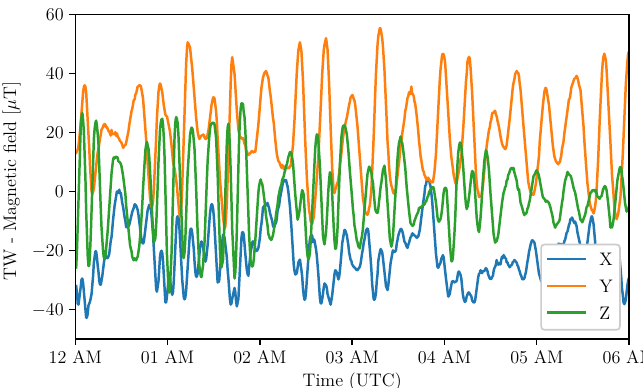
Figure 11. Magnetic field components on the x -axis, y -axis, and z